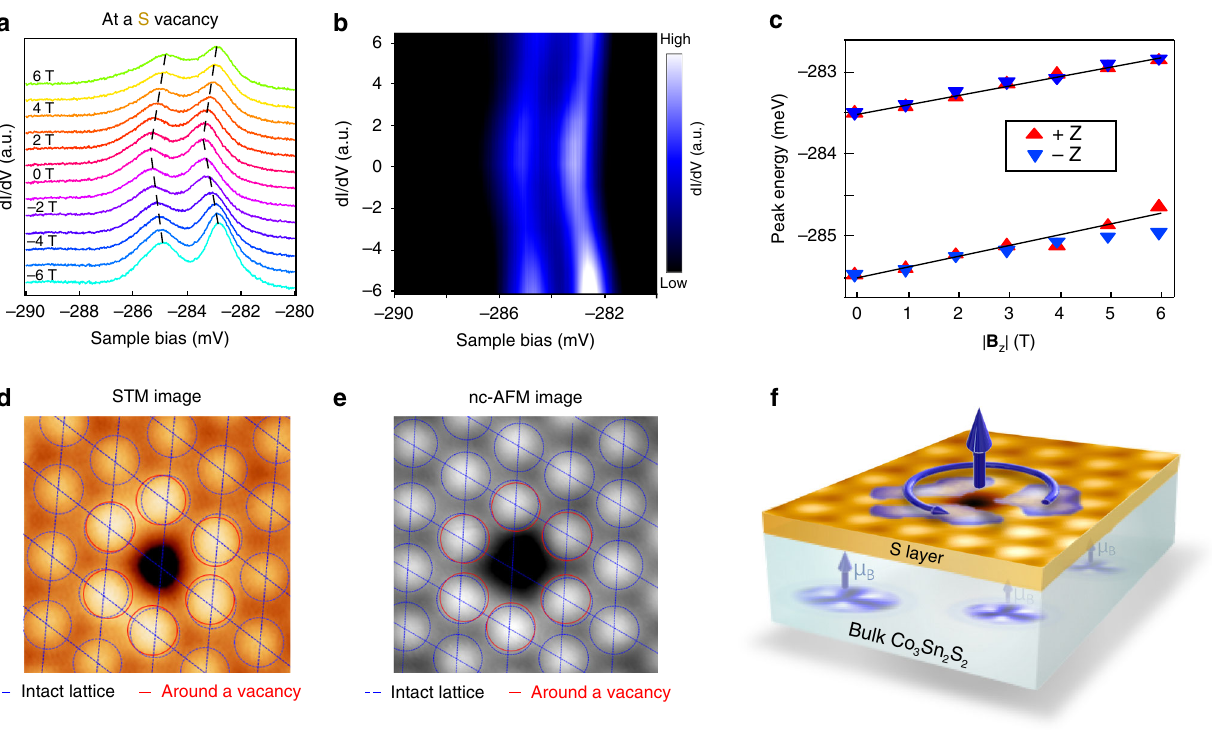
Fig. 4 Anomalous Zeeman shift of the bound states and spin-orbit polaron at a single S-vacancy. a d I /d V spectra of the bound states in a magnetic fi eld perpendicular to the sample surface from − 6 T to 6 T, showing an approximately linear shift independent of the magnetic fi eld direction. ( V − 400 mV, I t = 500 pA, V = 0.5 mV). b Intensity plot of a . c Energy shift of peak positions plotted as a function of the absolute value of magnetic fi eld. mod d , e STM and nc-AFM images (2.3 nm × 2.3 nm) of the same single S-vacancy, showing appreciable lattice distortion (detailed analysis please refer to Supplementary Fig. 10) around the single S-vacancy (STM: V s = − 400 mV, I t = 500 pA; AFM: Δ f = − 6 Hz). f Schematic illustration of the localized spin-orbit polaron in Co 3 Sn 2 S 2